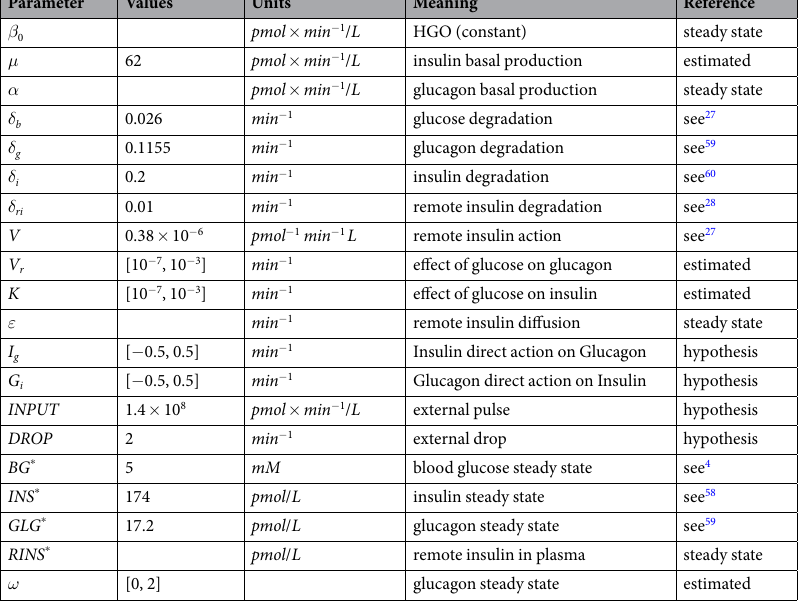
Table 1. Table of estimated parameters: parameters δ b , δ g , δ i , δ ri , V , BG * , INS * , GLG * are estimated from literature; parameters β 0 , α , ε , RINS * are evaluated from the steady state conditions in Equations (1–4), see Methods. Parameters μ , Vr, K, w are estimated as described in